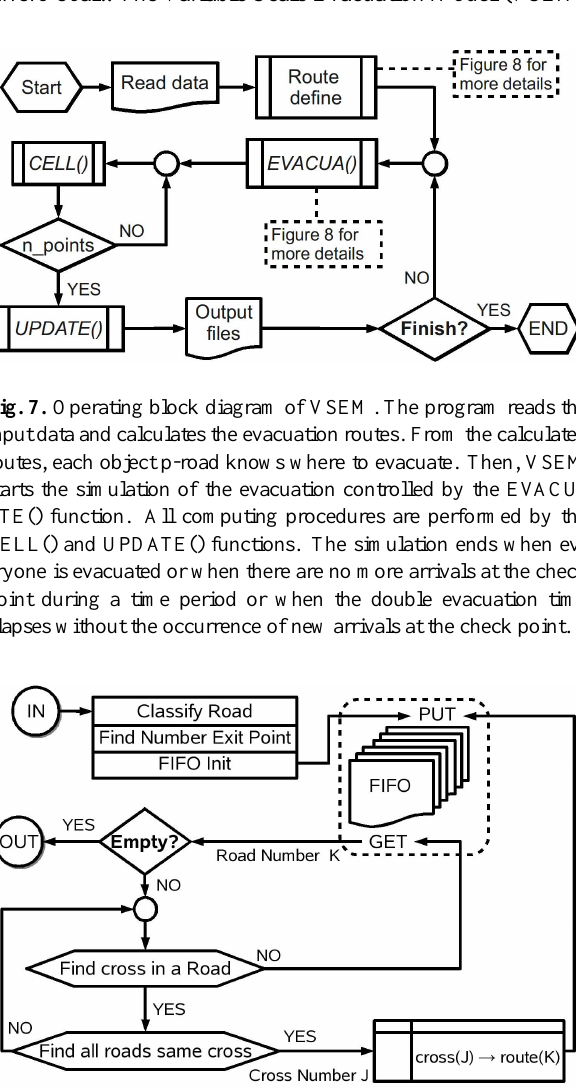
Fig. 8. FIFO queue diagram. First, VSEM sorts all p road objects and looks for exit points. Second, the FIFO queue is built and the first value assigned is the id number of the road where the exit point is situated. Third, all p road objects belonging to the same road are processed from the exit point backwards to find the crossroads (buffers). In each crossroads, the function analyses how many roads merge into it and stores the road id numbers in the evacuation route table and the FIFO queue. When all p road objects of a single road have been processed and no other crossroads have been detected, the search starts again with the next road id number in the FIFO queue. The process go on until FIFO queue is